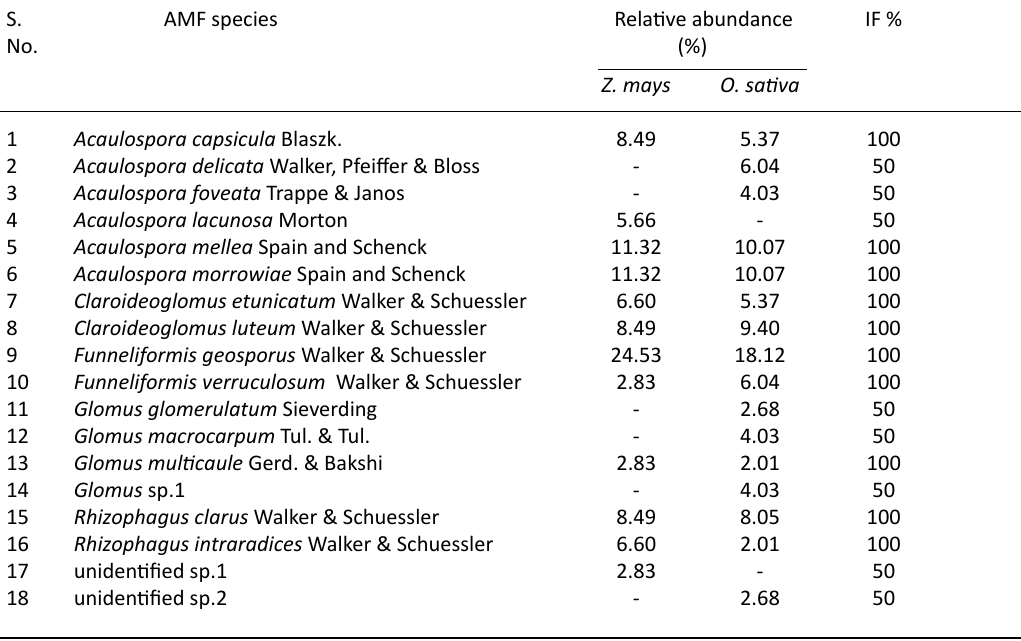
Table 2. AMF species isolated from trap cultures (10 years abandoned site derived inoculum) with their relative abundance and isolation frequency (IF) using Z. may s and O. sativa as trap plants